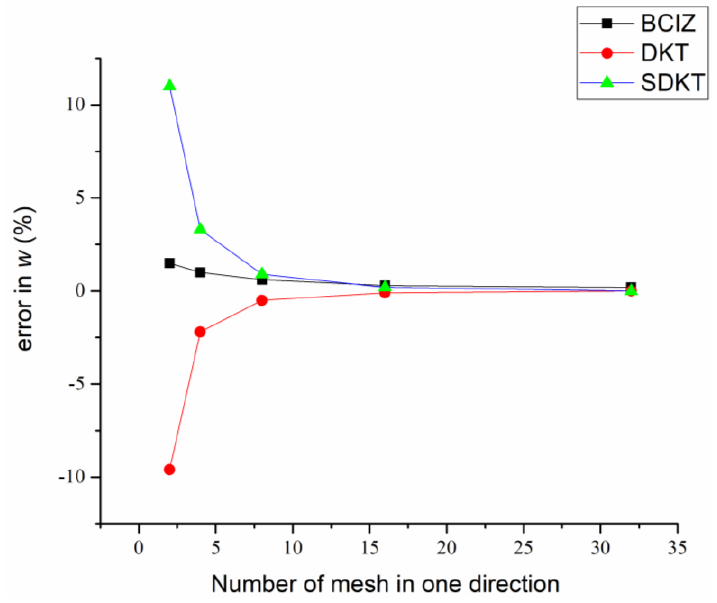
Figure 6. Error of the central deflection for a simply supported square plate under uniform load.